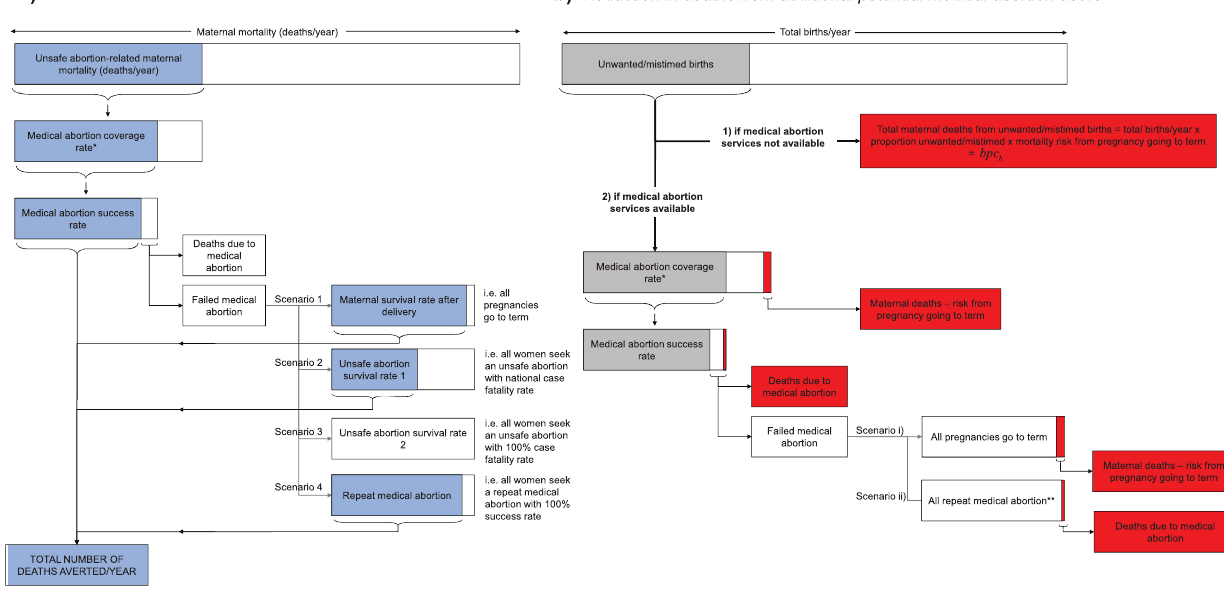
Figure 2. Schematic illustrating method of estimating deaths due to unsafe abortion averted by introducing medical abortion, representing a) the reduction in deaths from unsafe abortions averted and b) the reduction in deaths from the risk associated with pregnancy going to term, for additional potential users of abortion services. For b), deaths averted are the difference between number of deaths from route 1), where medical abortion is not available, and route 2) where they are available. Fractions for each bar are not drawn to scale. * Defined as women who would have accessed unsafe abortion services but preferentially seek medical abortion services, if available. ** Assumes that a repeated medical abortion is 100% effective.